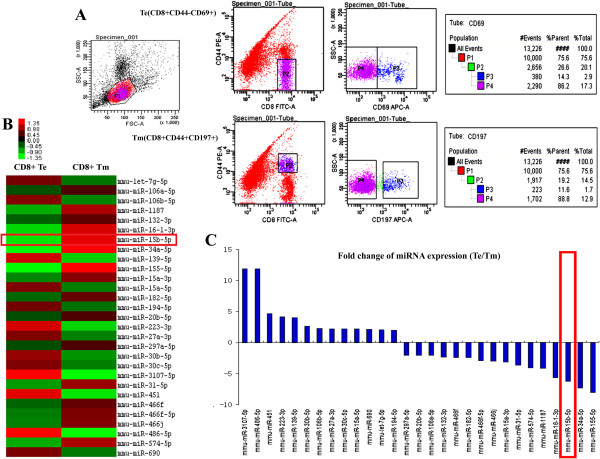
The expression of miRNA-15b between CD8+ effector T (Te) cells and memory T (Tm) cells from the spleens of tumor-burdened mice. A) CD8+ Te cells labeled with CD8 + (FITC)CD44-(PE)CD69 + (APC) and CD8+ Tm cells labeled with CD8 + (FITC)CD44 + (PE)CD197 + (APC) were purified by fluorescence-based cell sorting. B) Diagram shows the differentially expressed miRNAs between CD8+ Te and Tm cells. Each row represents a single miRNA. Red color represents that the miRNA was highly expressed and green color represents low expression level. C) Main miRNAs which were differentially expressed in CD8+ Te and Tm cells were listed. 9 of them were down-regulated and 15 of them were up-regulated in Tm cells.